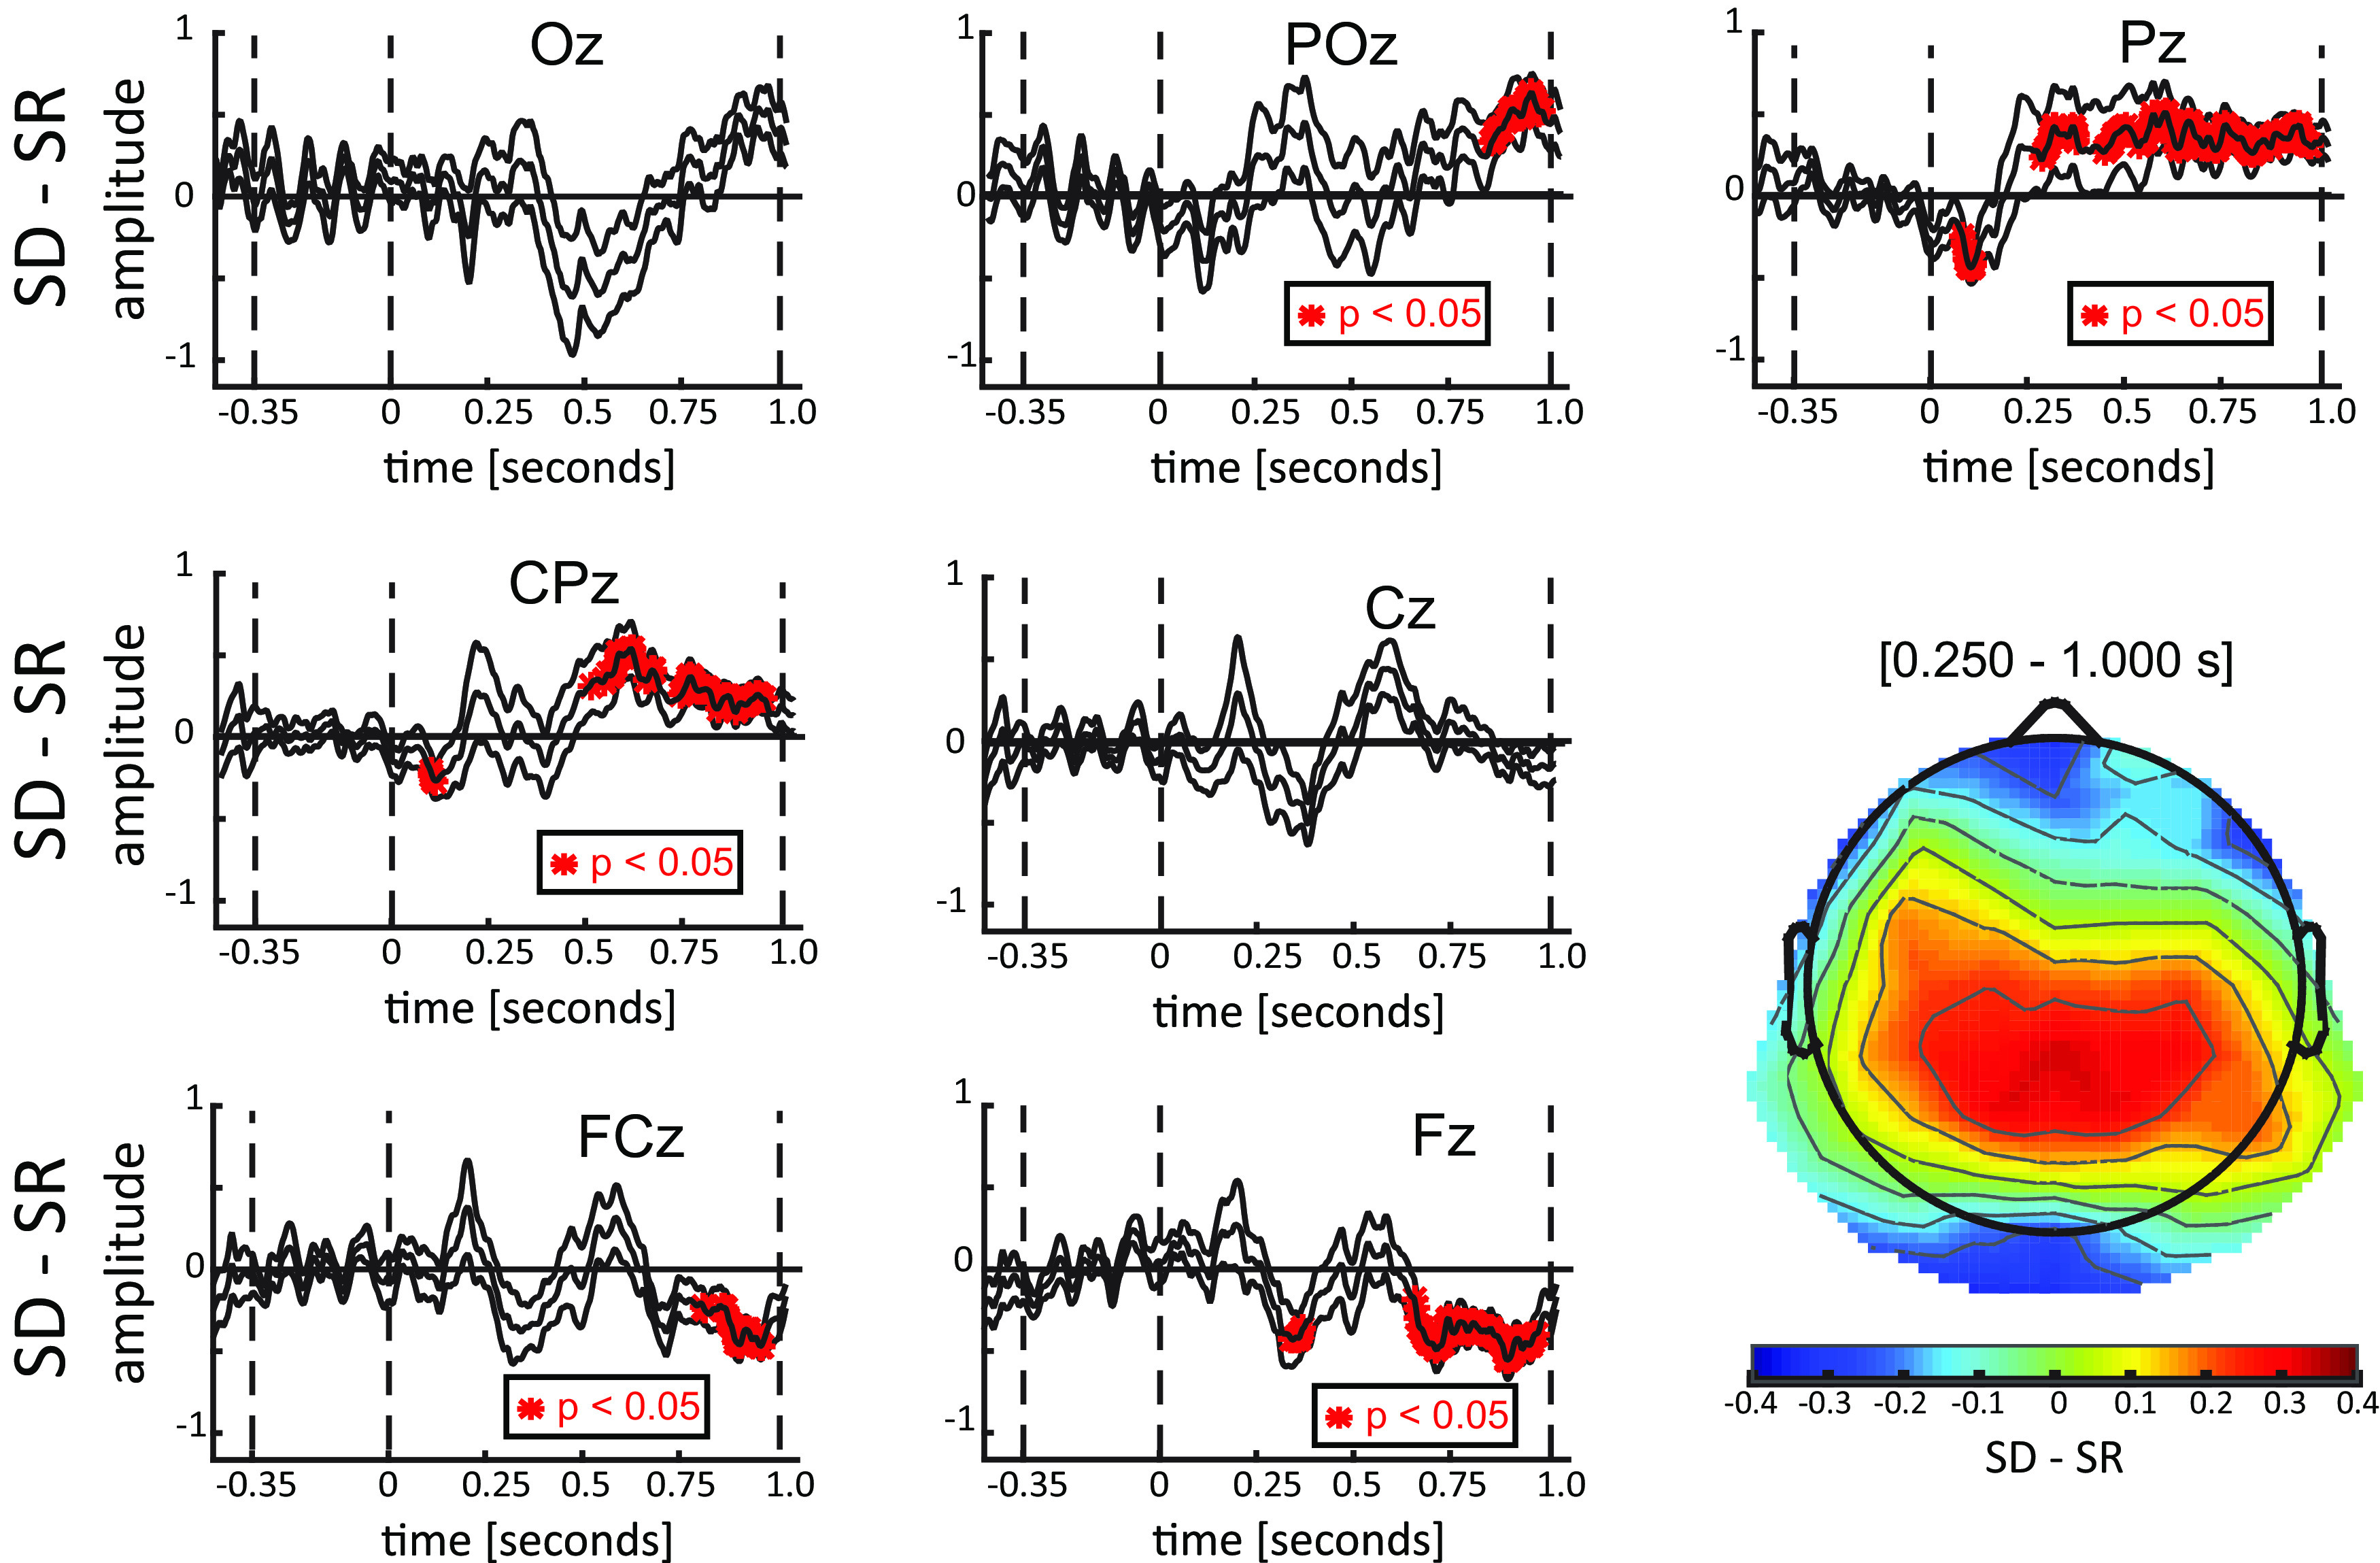
ERPs results. Each panel represents the difference between ERPs elicited in the SD and SR conditions for the seven midline electrodes (average ± SE). Shown in red are the points for which a significant difference was found against zero. The results reveal a significant difference from 250 ms after stimuli onset until the response cue (at 1000 ms) in central parietal regions, and an opposite effect after 750 ms in frontal regions. In the bottom-right panel, the topography, computed over the 250- to 1000-ms interval, confirmed a larger activity in the SD than in the SR condition (positive difference, warmer colors) in the central-parietal regions, and an opposite effect (negative difference, colder colors) in the frontal regions (which, although not significantly, also included occipital regions).